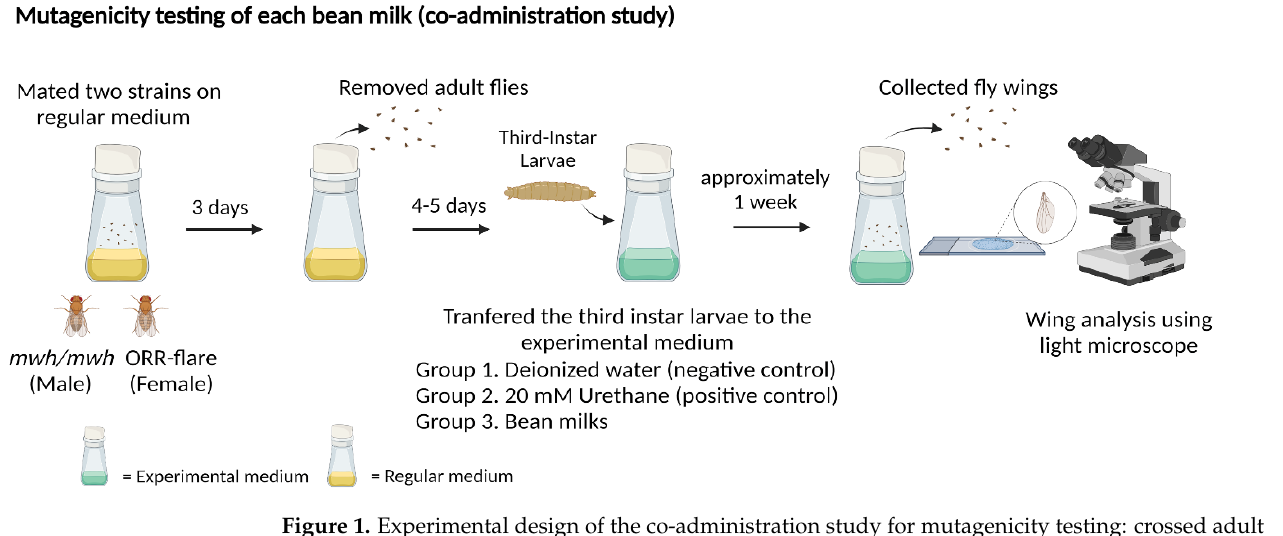
Figure 1. Experimental design of the co-administration study for mutagenicity testing: crossed adult flies were fed on the regular medium and the third instar larvae were transferred to the experimental medium containing each bean milk, water (negative control) or 20 mM urethane (positive control). Wings were collected and analyzed for mutant spots.